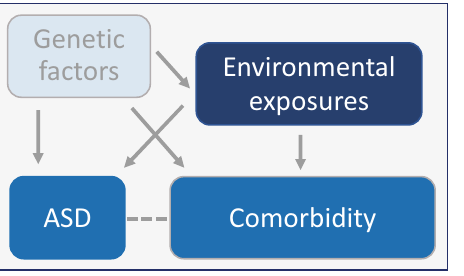
Fig. 5 Schematic illustrating potential relationships between genetic vectors, environmental exposures, ASD and its comorbid